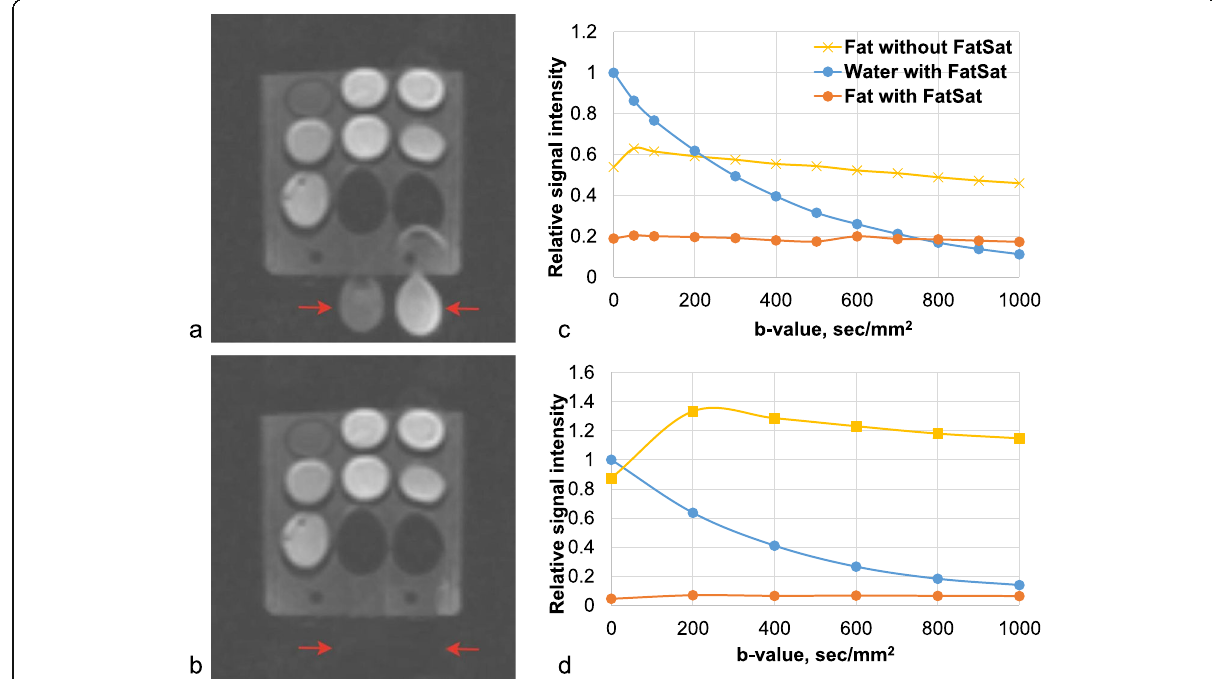
Fig. 5 Fat saturation quality assurance with the QA-DWI phantom. a DWI ( b = 1000) with inadequate fat suppression. b DWI ( b = 1000) with adequate fat suppression. Red arrows indicate an extracorporeal signal from the oils. c – d Signal intensities of fat and water relative to water at a b -factor of 0 s/mm 2 for inadequate ( c ) and adequate ( d ) fat suppression